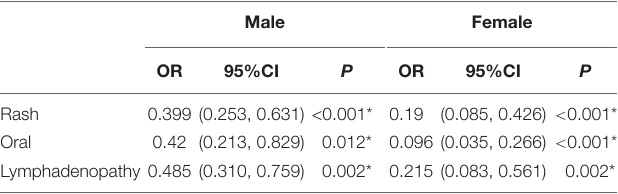
TABLE 5 | Logistic regression analysis of rash, oral and lymphadenopathy in male and female patients.